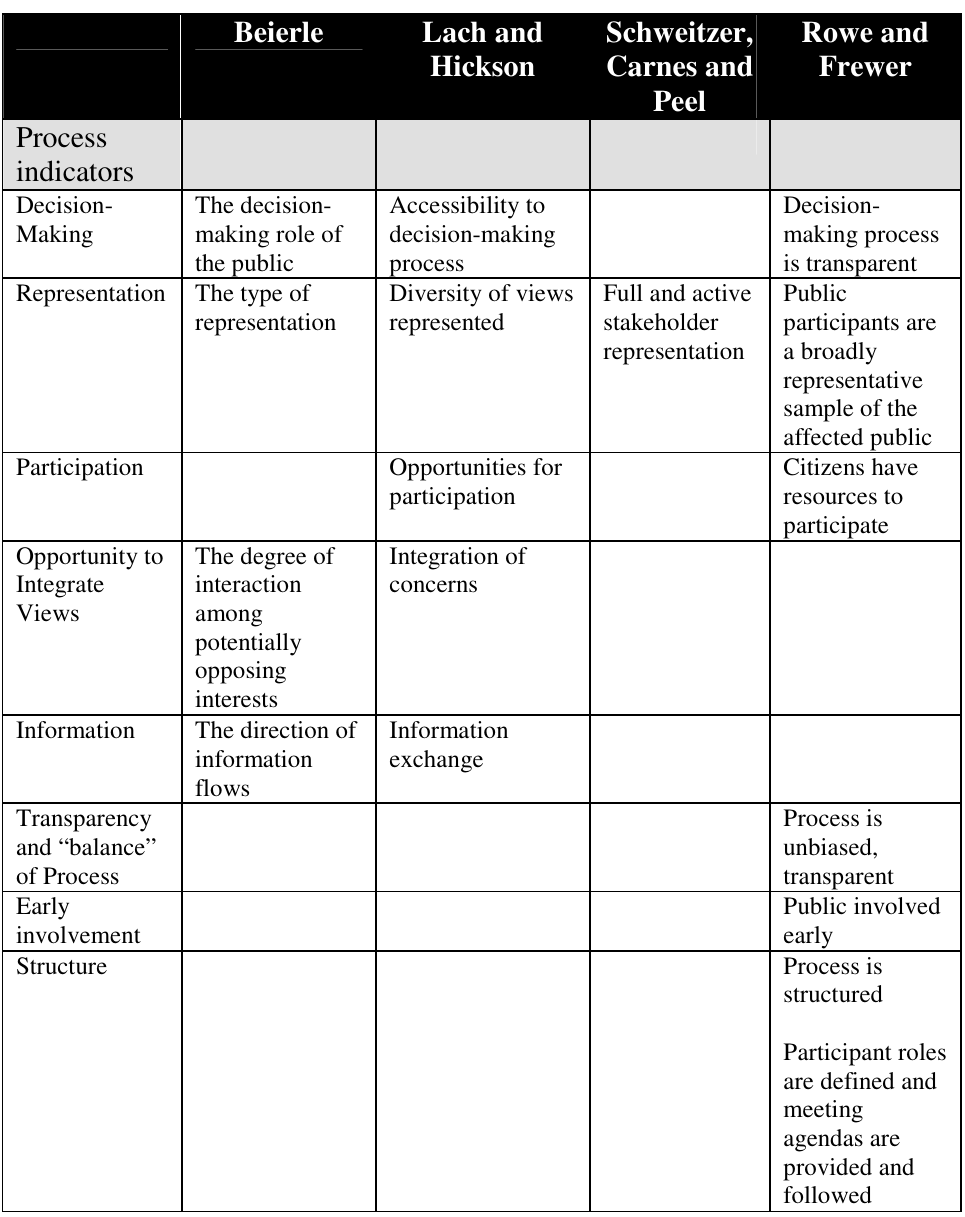
Table 1: Public Participation Evaluation Indicators: A Comparison Beierle Lach and Schweitzer, Rowe and Hickson Carnes and Peel